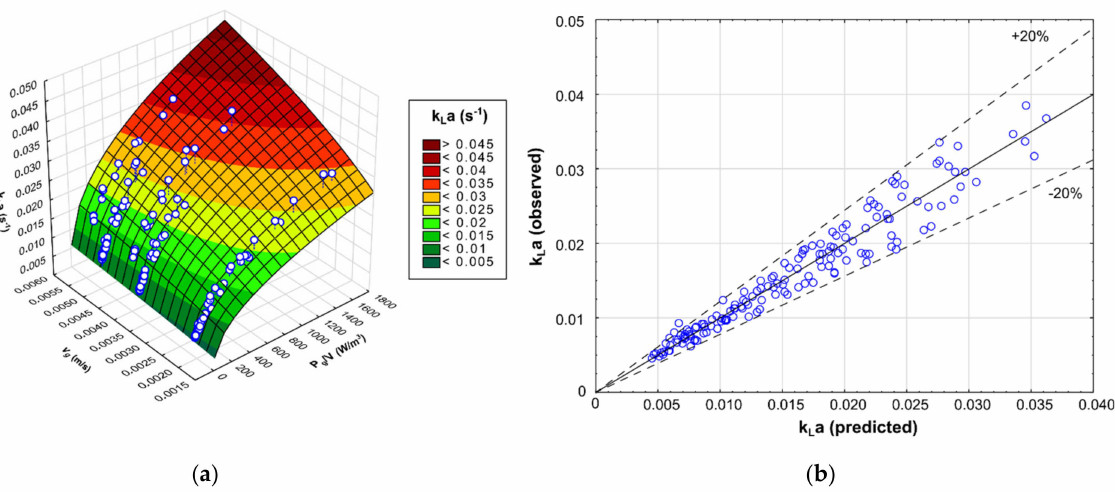
Figure 8. Verification of Equation (12): ( a ) experimental data and model, ( b ) predicted and observed values of k L